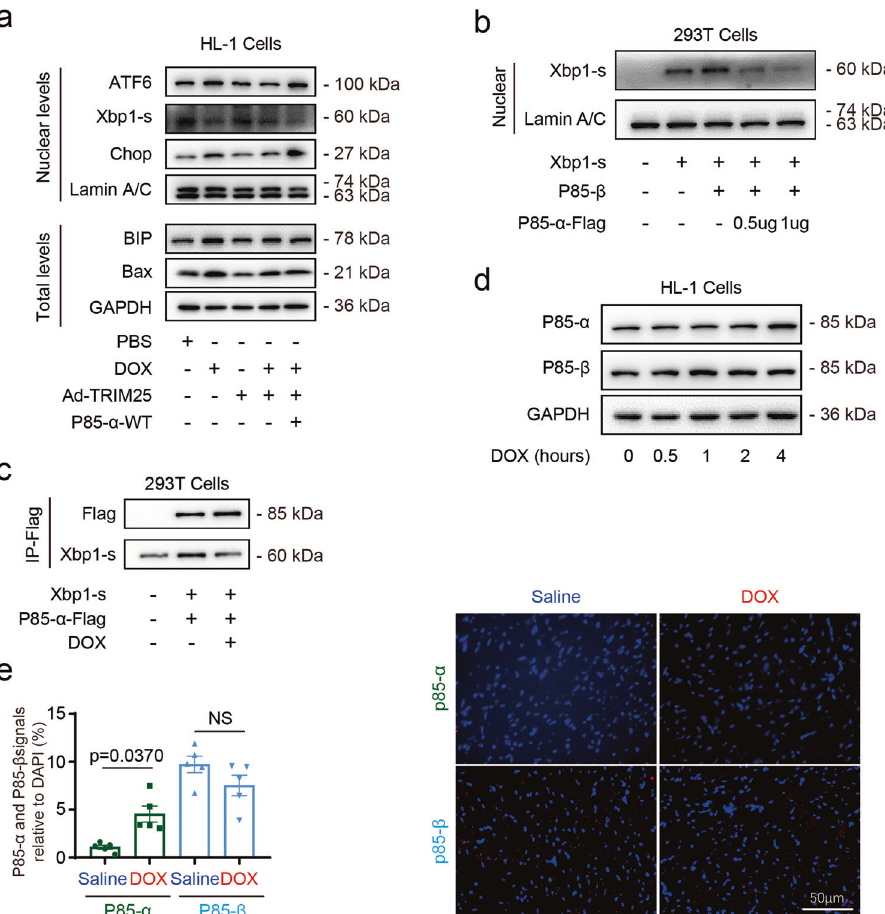
(Fig. 7e, f). Western blotting revealed the role of p85 α in UPR